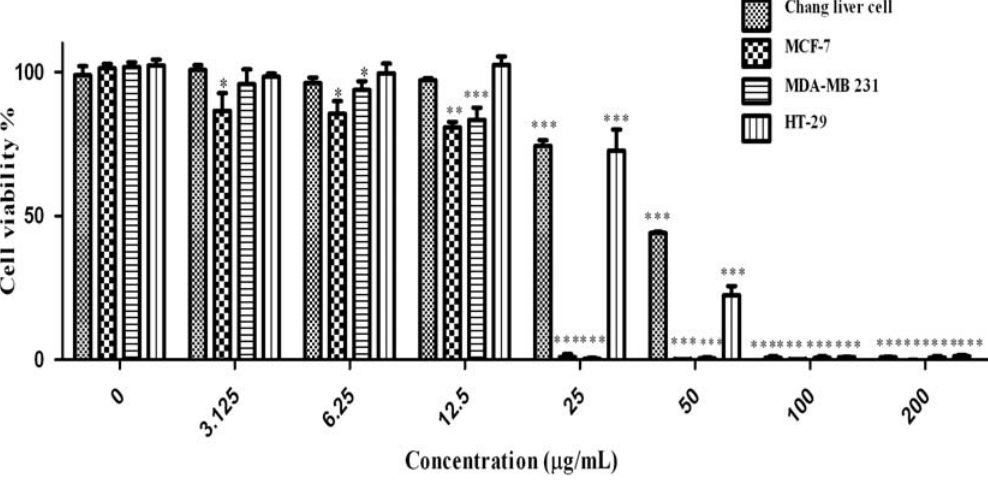
and HT-29 cells survival. All values represent the mean ± S.E.M from three